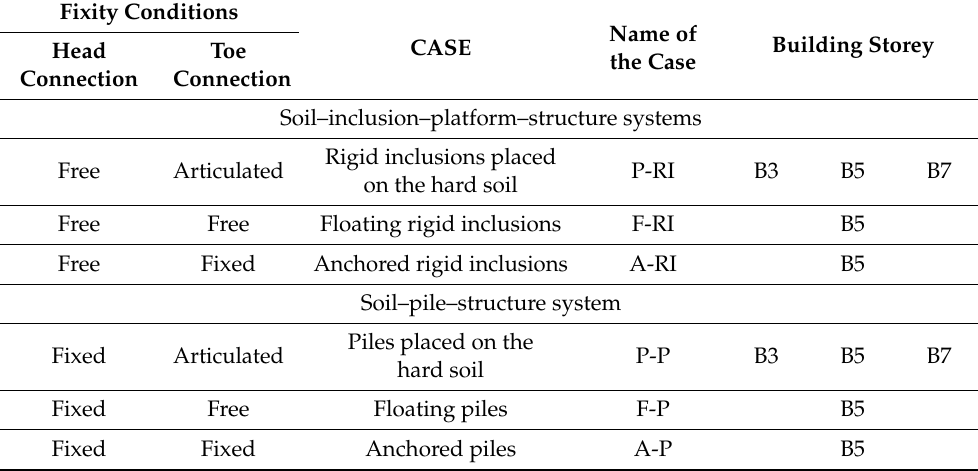
Table 6. Cases and fixity conditions for the vertical